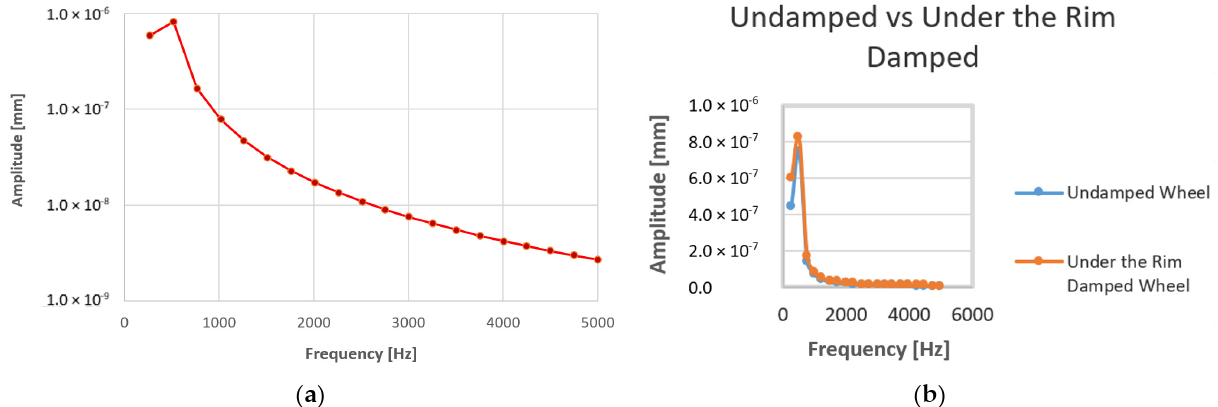
Figure 19. Harmonic response analysis in the lateral direction with viscoelastic damping layer under the rim of both sides of the wheel. ( a ) The lateral excitation on the wheel mounted with viscoelastic layer under the rim on both sides of the wheel. ( b ) Lateral results of the wheel mounted with and without viscoelastic layer under the rim on both sides of the